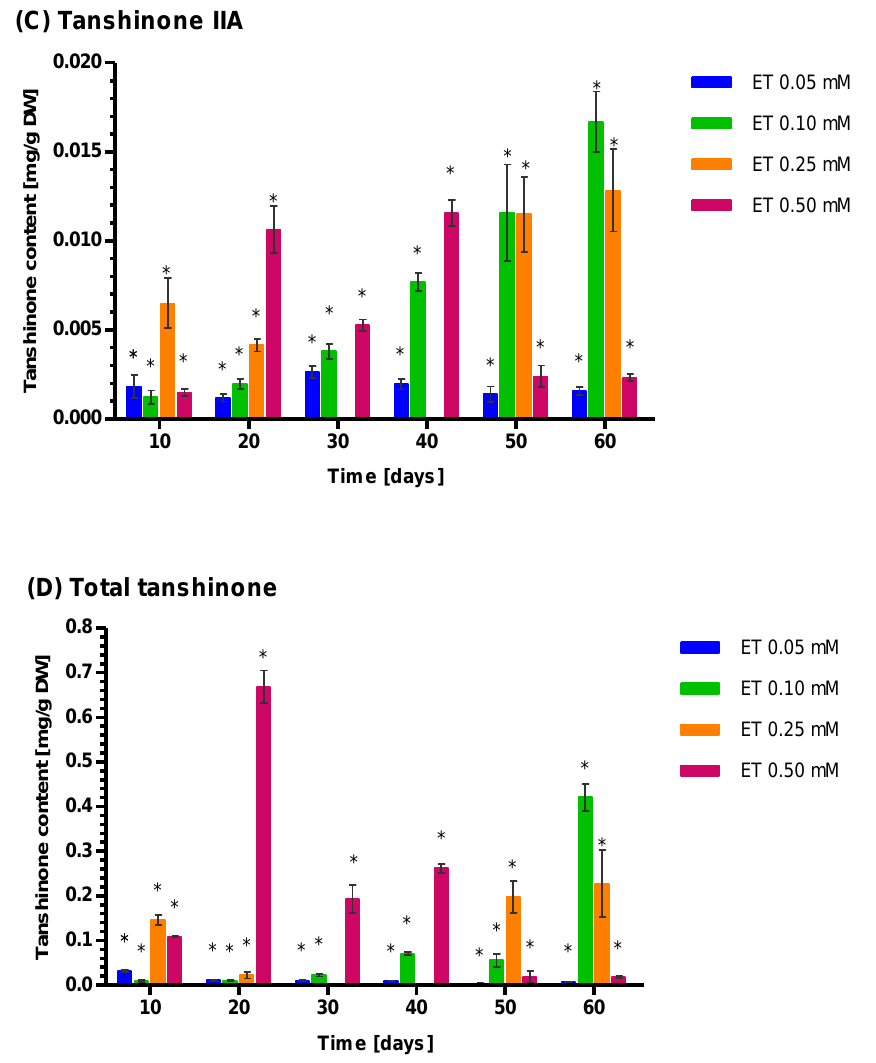
Figure 5. Concentration of three tanshinones dihydrotanshinone I ( A ), cryptotanshinone ( B ), tanshi- none IIA ( C ), and total tanshinone ( D ) in S. miltiorrhiza callus presented as a function of ethephon(ET) concentration (0.05, 0.10, 0.25, and 0.50 mM) and elicitation time of 10–60 days. Control and tanhinone I values were not detectable. Differences between control (0) and non-zero tested samples were statistically significant according to the Wilcoxon signed-rank test at p < 0.01. Significant results were marked by an asterisk (*).